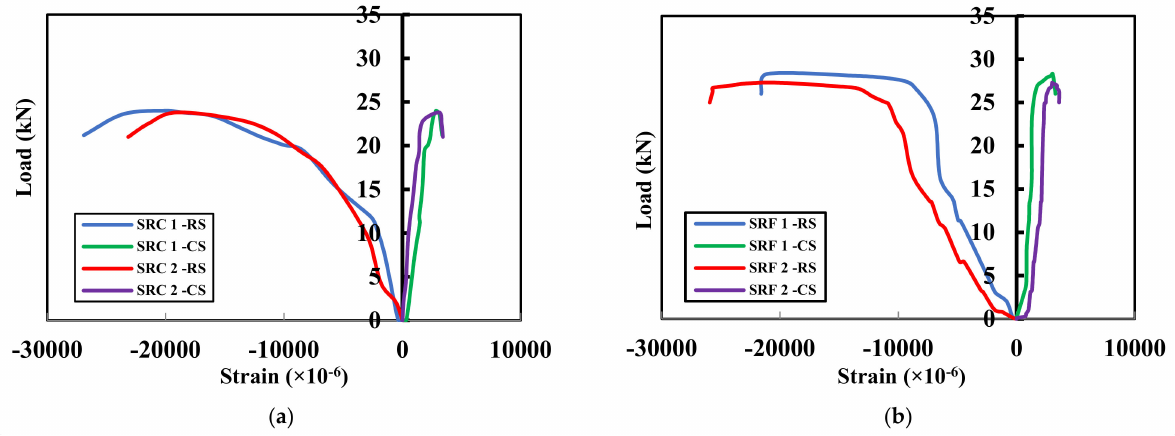
Figure 10. Load–strain behavior of ( a ) SRC and ( b ) SRF. RS—reinforcement strain; CS—concrete strain.